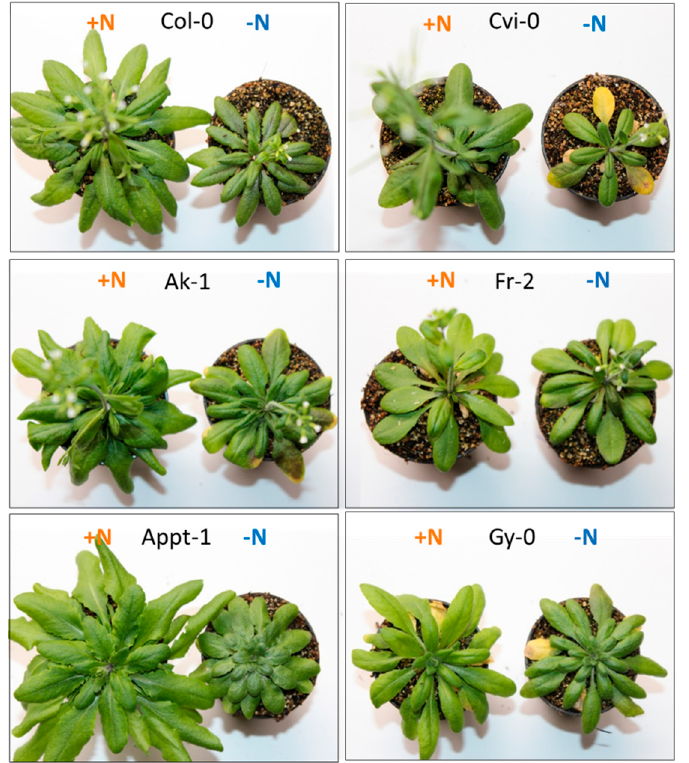
Figure 5. Representative pictures of plants grown under +N (left/orange) and − N (right/blue) conditions in a vermiculite-based substrate. Shown are representative plants of the Arabidopsis thaliana accession Col-0 , Cvi-0 , Ak-1 , Fr-2 , Appt-1 and Gy-0 grown for 44 days on 70% vermiculite/ 30% soil mixture supplemented with Estelle and Somerville medium to achieve +N (9 mM nitrate) and − N (0.4 mM nitrate) conditions.